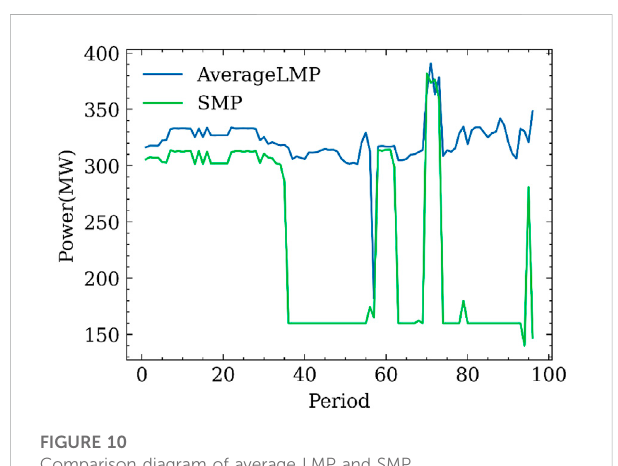
FIGURE 10 Comparison diagram of average LMP and